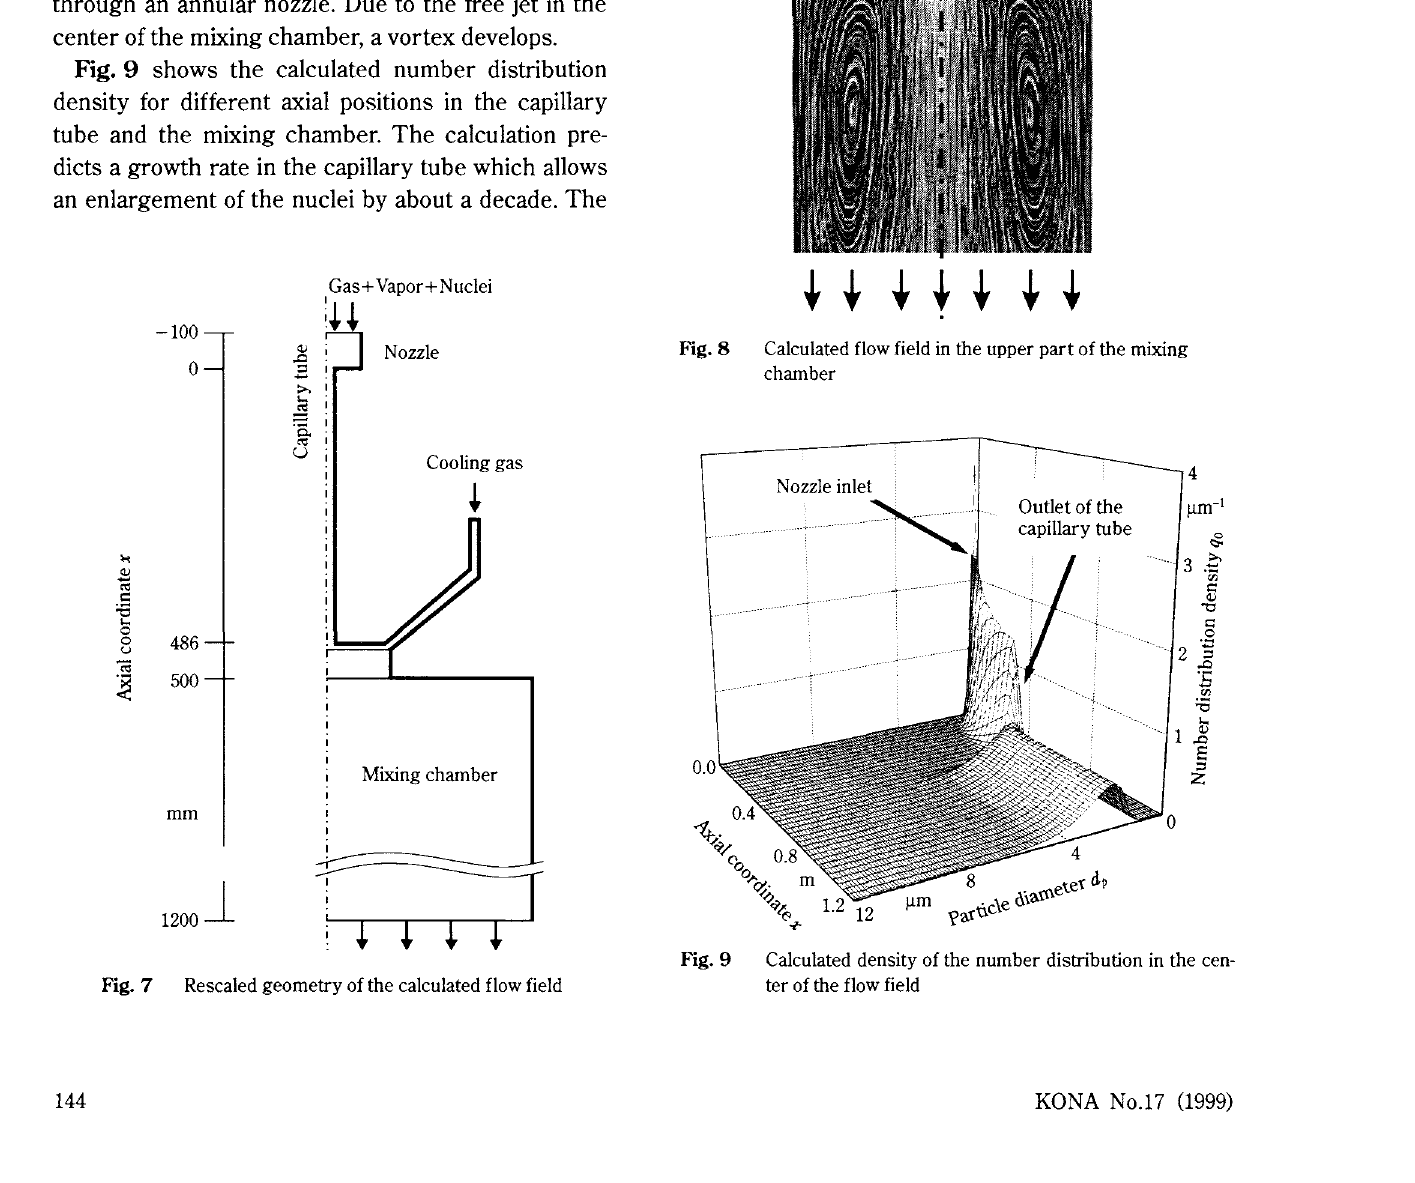
Calculated density of the number distribution in the cen ter of the flow field